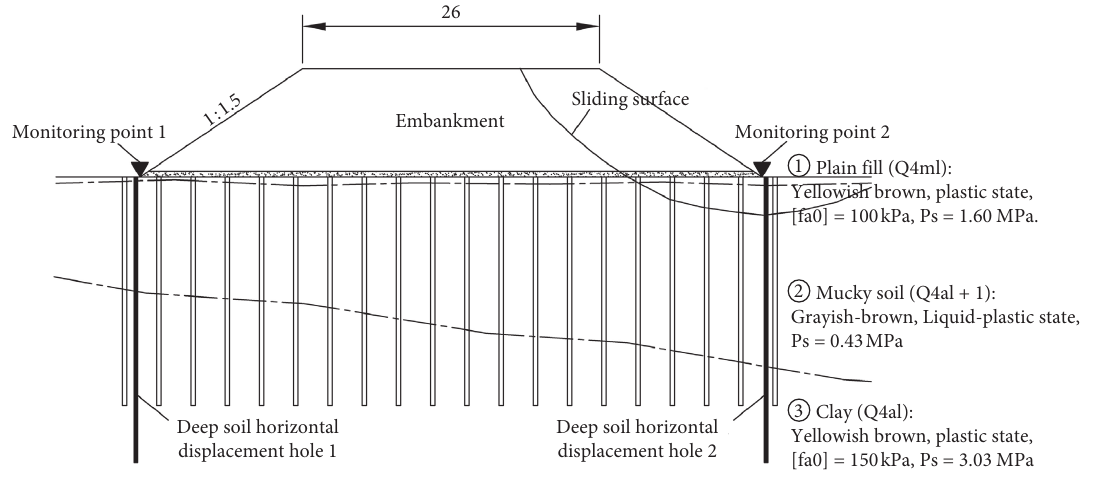
Figure 3: Diagram of the subgrade section.